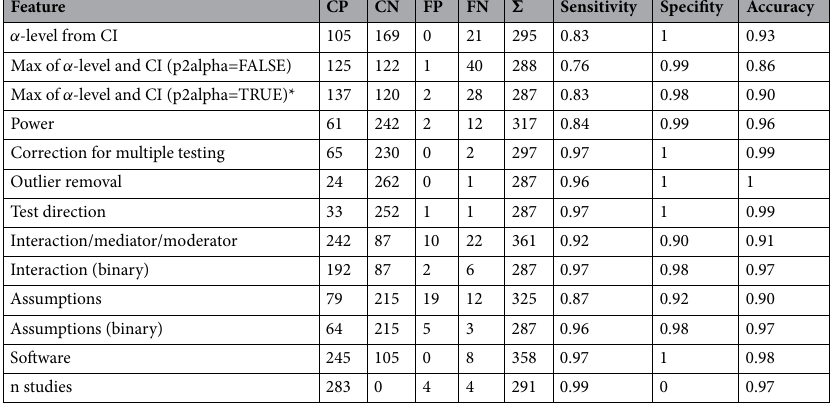
Table 3. Sensitivity, specificity and accuracy of study.character ’s extractions. Detections may sum up to values > N = 287 as results may be multidimensional and false positives are included. *Default setting of study. character.